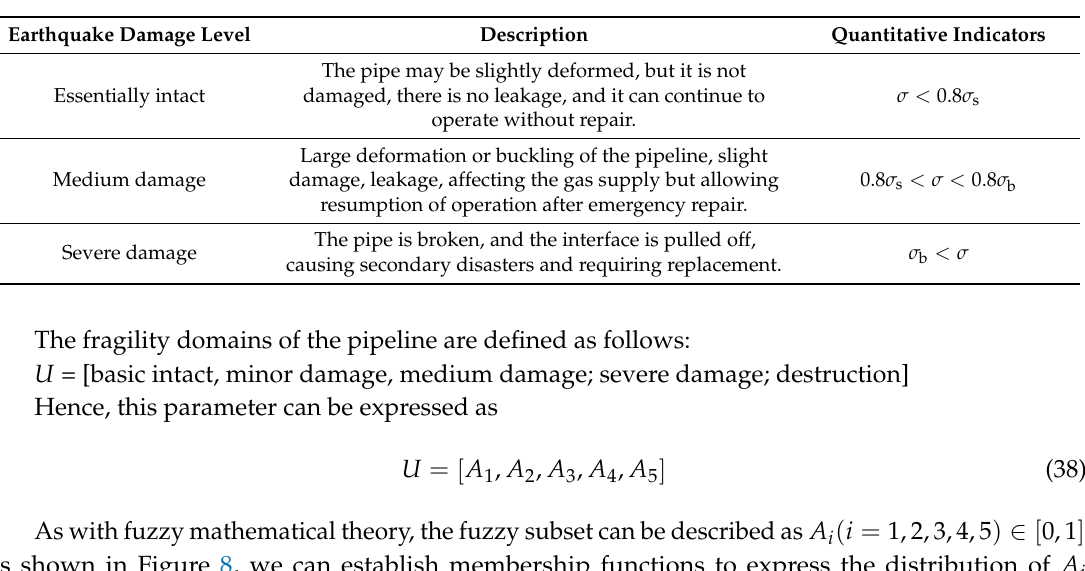
Table 7. Division of the degree of damage to